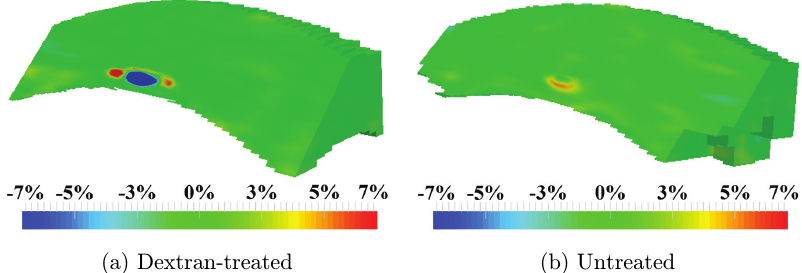
Fig. 4. (Color online) Maps of the second principal strain " 2 obtained in (a) dextran-treated, and (b) untreated globes after in°ation from 10 mmHg to 12 mmHg.